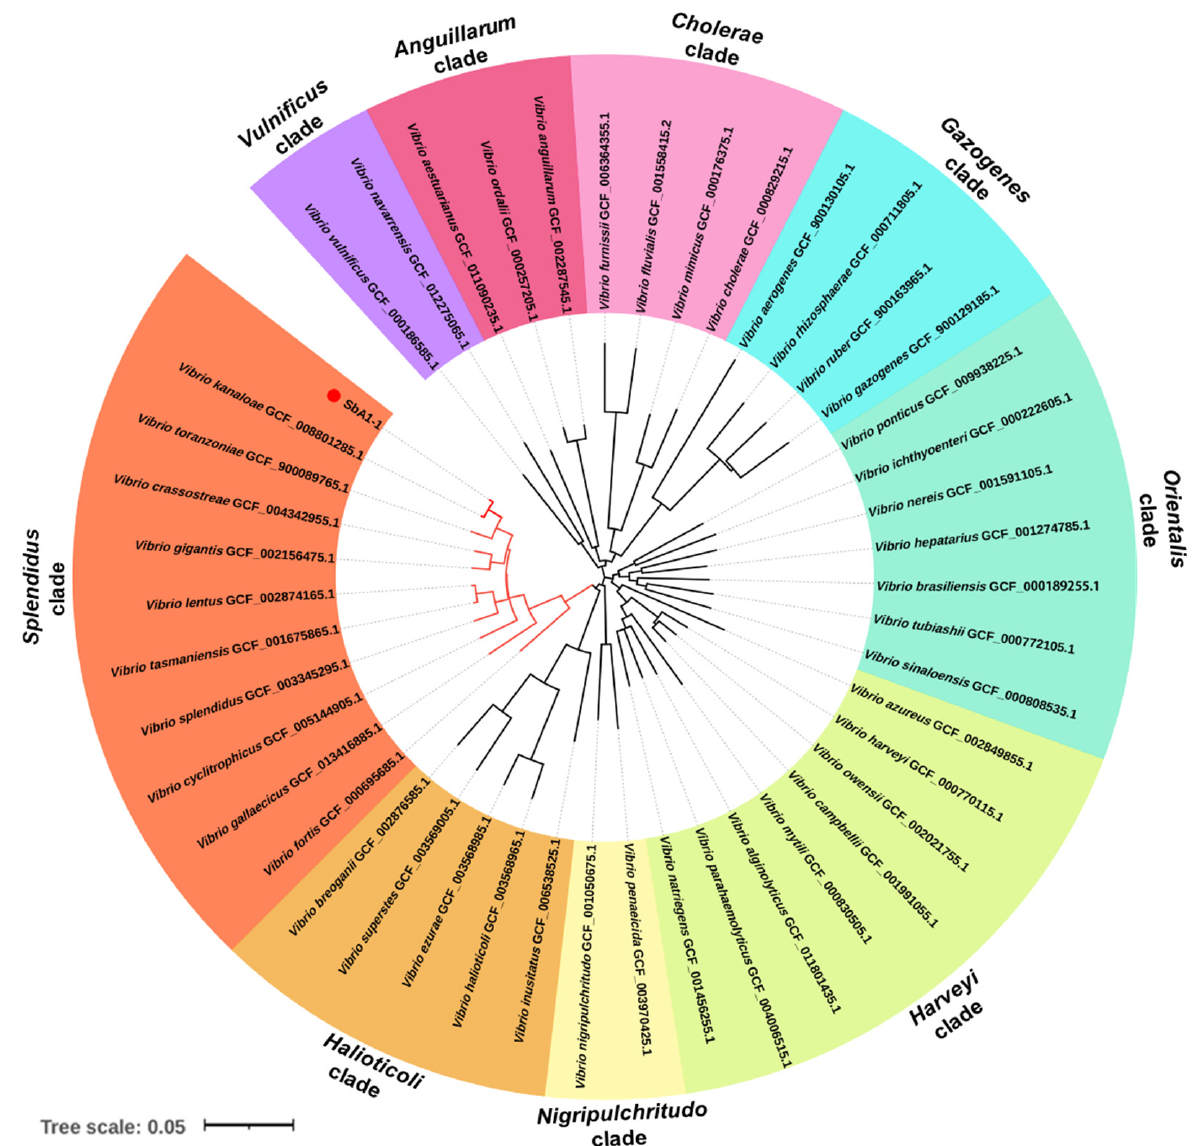
Figure 4. Phylogenetic tree of bacteria ( V. kanaloae strain SbA1-1) based on concatenated sequences of atpA , mreB , pyrH , recA and rpoA genes (4958 nt) using the NJ method and visualized in iTOL v6.1.1. (https://itol.embl.de/, accessed on 26 March 2021). The colored sectors indicate distinct Vibrio clades. The scale bar corresponds to 0.05 substitutions per site.